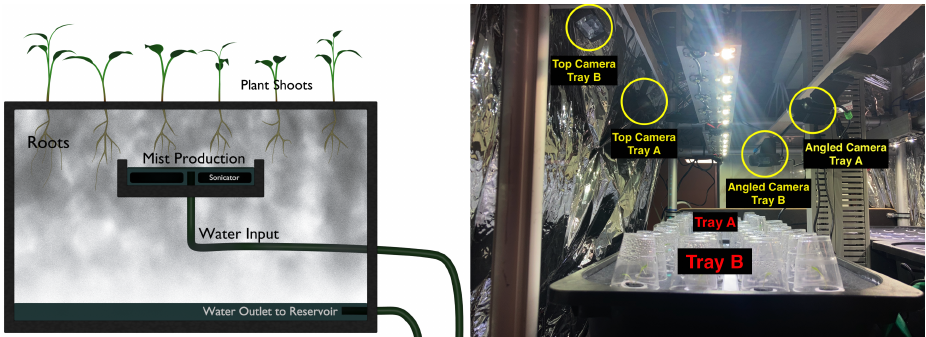
Figure 1. Growth bed schematic from the side ( left ). Camera rig for image capture ( right